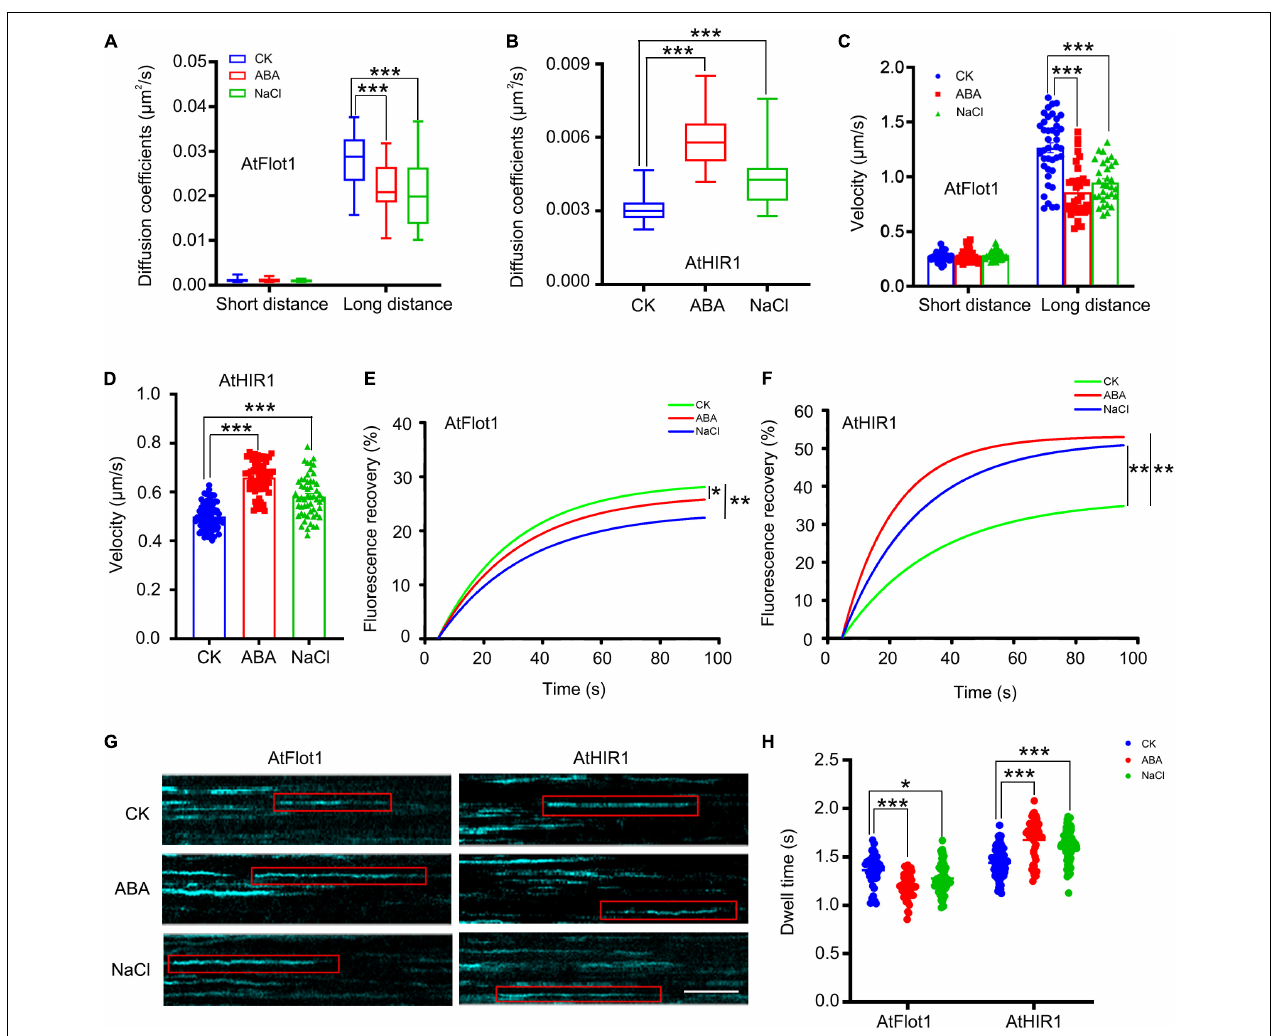
FIGURE 7 | Dynamics of GFP-AtFlot1 and AtHIR1-GFP at the PM under control and ABA and NaCl treatment conditions. (A) Long-distance and short-distance diffusion coefficients for GFP-AtFlot1 under different conditions. For each examination, at least 30 cells from each of five seedlings were examined. In each case, three biological replicates were performed. Statistical significance was determined using Student’s t -tests (*** P < 0.001). (B) Diffusion coefficients of AtHIR1-GFP in different environments. For each examination, at least 30 cells from each of five seedlings were examined. In each case, three biological replicates were performed. Statistical significance was determined using Student’s t -tests (*** P < 0.001). (C) The velocity of GFP-AtFlot1 under different conditions. For each examination, at least 30 cells from each of five seedlings were examined. In each case, three biological replicates were performed. Statistical significance was determined using Student’s t -tests (*** P < 0.001). (D) The velocity of AtHIR1-GFP under different conditions. For each examination, at least 30 cells from each of five seedlings were examined. In each case, three biological replicates were performed. Statistical significance was determined using Student’s t -tests (*** P < 0.001). (E) Fluorescence recovery curves of the photobleached region of interest in GFP-AtFlot1 cells under control and ABA and NaCl treatment conditions. For each examination, at least 15 cells from each of five seedlings were examined. In each case, three biological replicates were performed. Statistical significance was determined using Student’s t -tests (* P < 0.05; ** P < 0.01). (F) Fluorescence recovery curves of the photobleached region of interest in AtHIR1-GFP cells under control and ABA and NaCl treatment conditions. For each examination, at least 15 cells from each of five seedlings were examined. In each case, three biological replicates were performed. Statistical significance was determined using Student’s t -tests (** P < 0.01). (G) Representative kymographs showing individual GFP-AtFlot1 and AtHIR1-GFP dwell times in the presence of the control, ABA, and NaCl treatments. Bar = 2 s. (H) Dwell times of GFP-AtFlot1 and AtHIR-GFP treated with control, ABA, and NaCl.